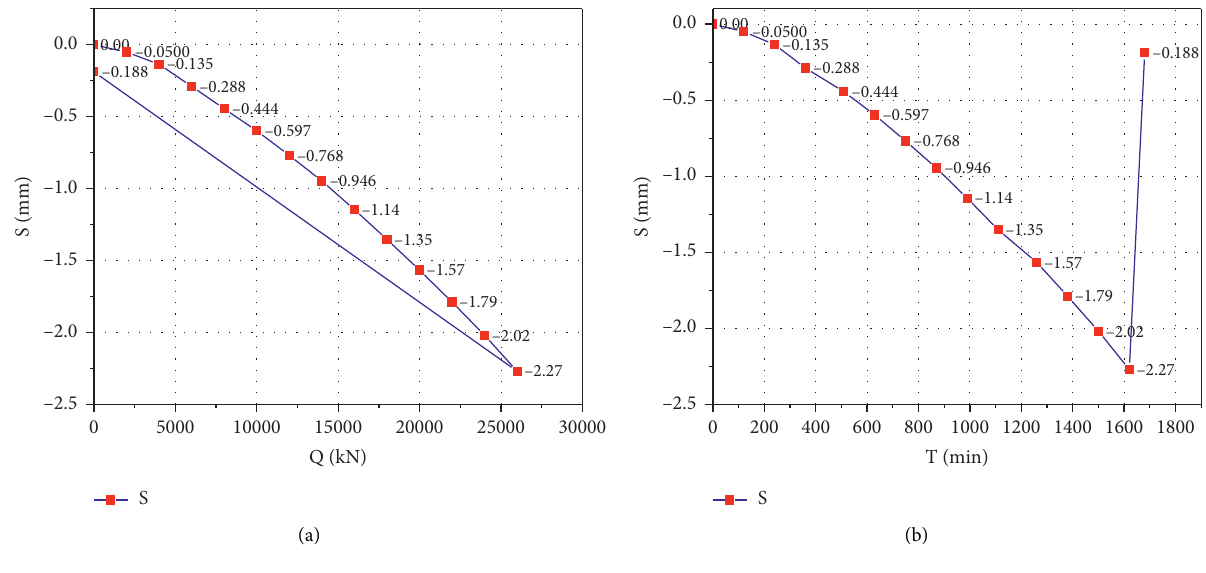
Figure 13: The Q - S (a) and T - S (b) curves obtained by SLT.